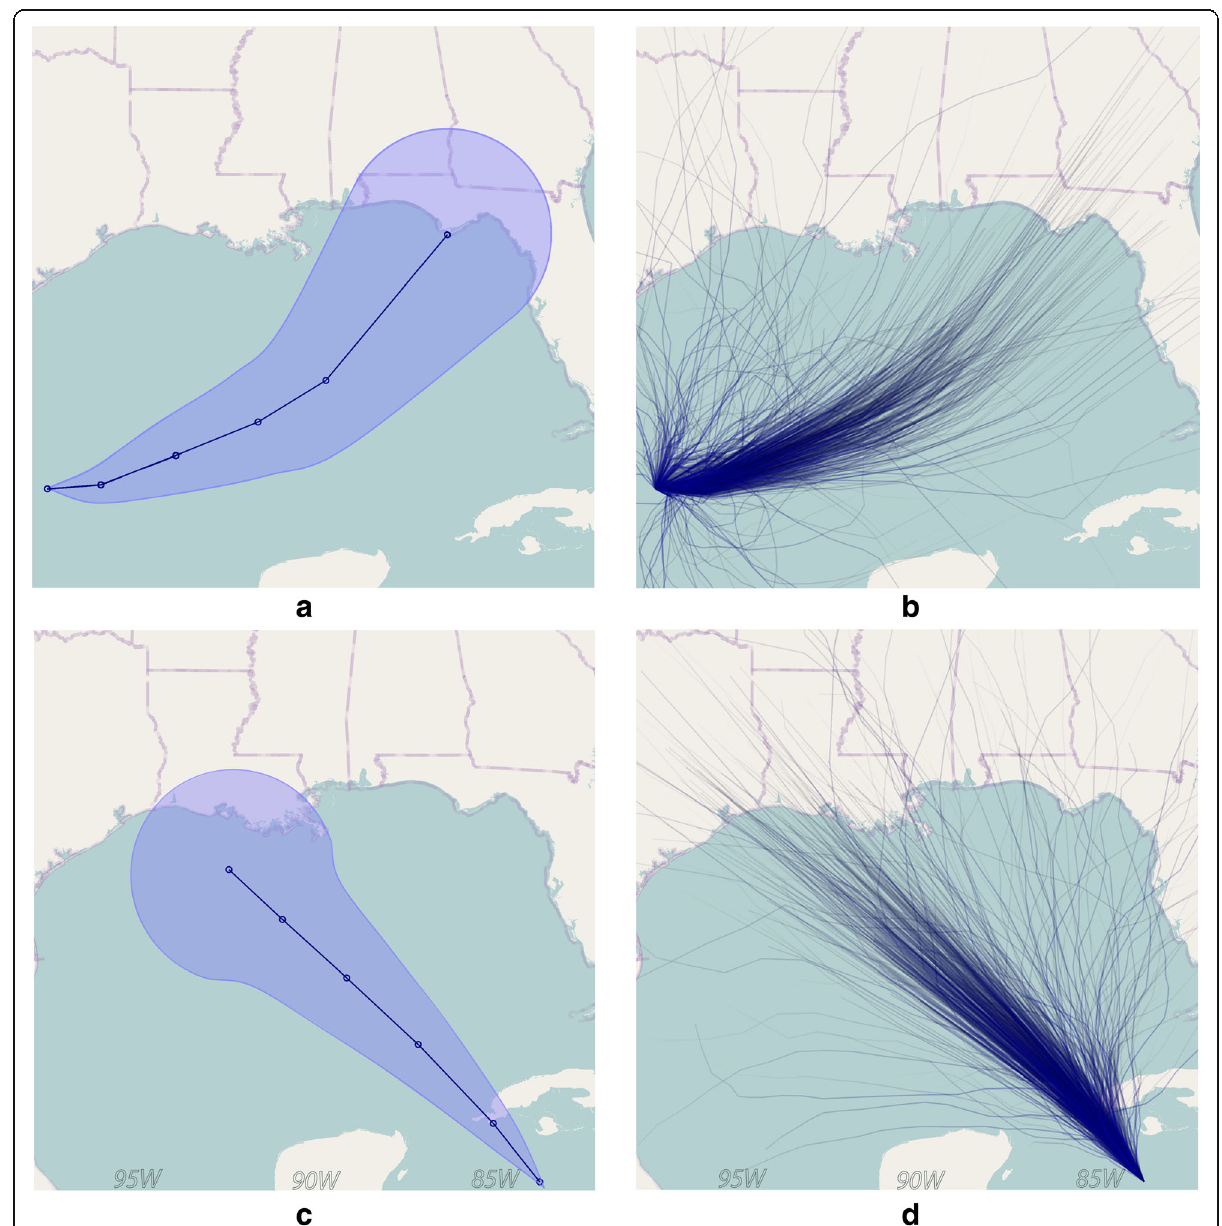
Fig. 2 Examples of the cone ( a , c ) and ensemble display ( b , d ) visualization techniques of hurricane one ( a , b ) and two ( c , d